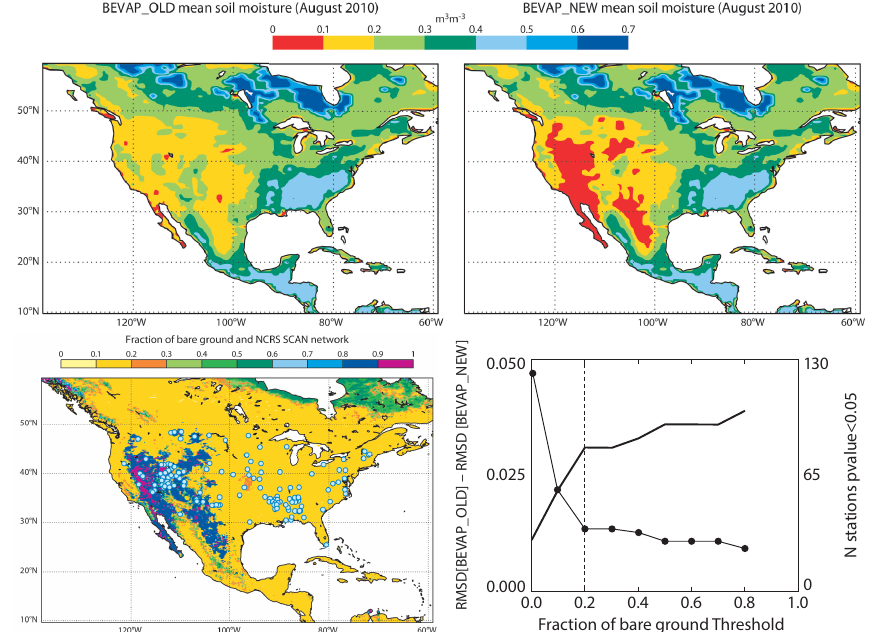
Figure 7. Mean soil moisture in the ECMWF model (August 2010), before (BEVAP OLD, upper left ) and after (BEVAP NEW, upper right ) the bare soil evaporation revision, evaluated using the US in situ soil network ( lower left ) to calcuate the difference in soil moisture Root Mean Square Error when using the revised bare soil evaporation threshold instead of the old model version (curve with dots, lower right )). The solid curve indicates the number of in situ observations in each of the bare soil fraction classes. For further details, see Figures 1, 2, 4 and 5 in